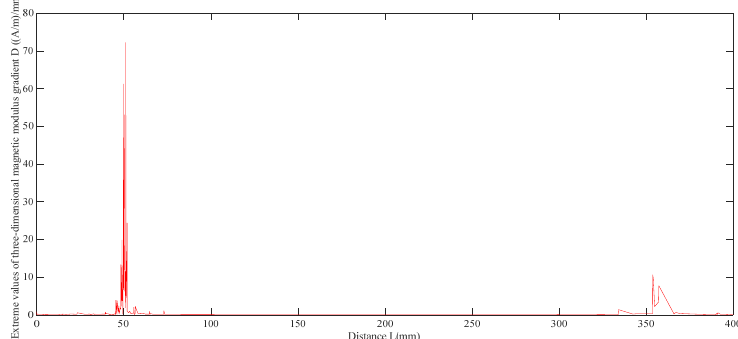
Figure 9. Extreme values of three-dimensional magnetic modulus gradient.